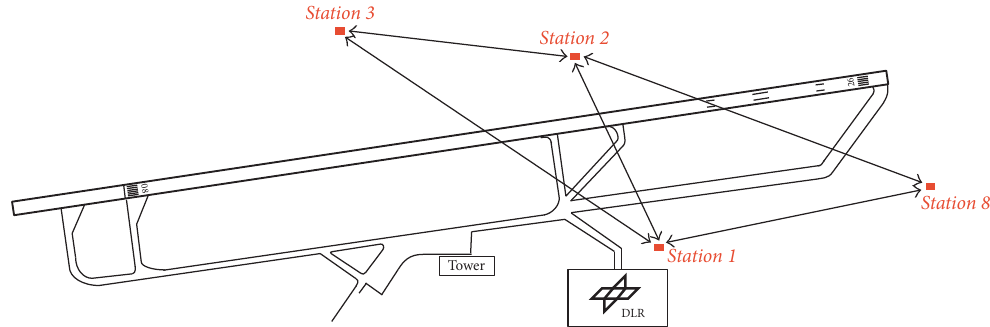
Figure 4: Layout of the GBAS reference stations at Braunschweig Airport as used during the flight trials.